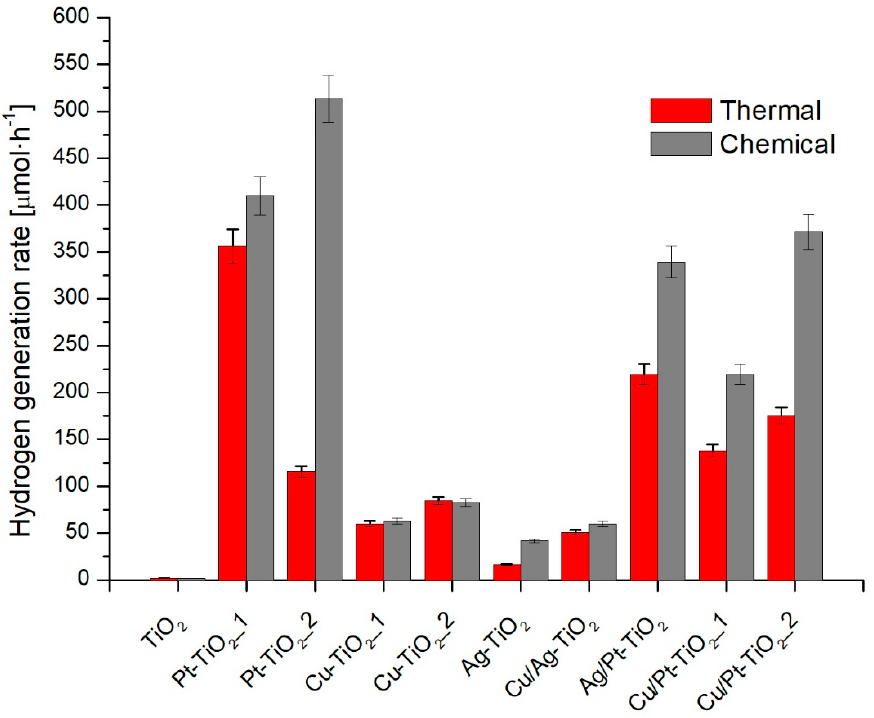
Figure 6. Photocatalytic activity in hydrogen generation under UV-Vis.